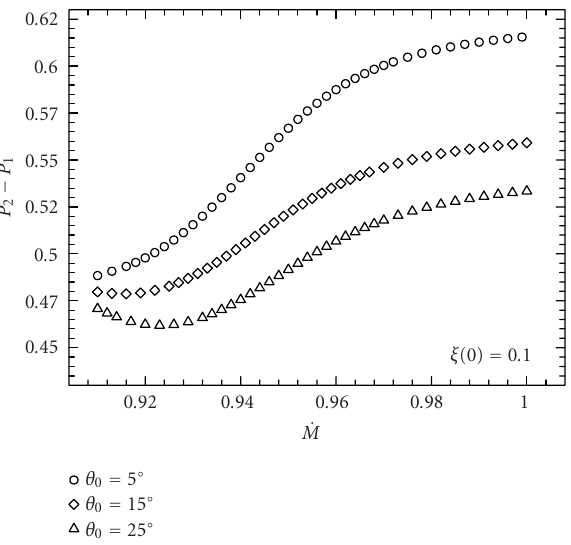
Figure 17: The computed compressor static pressure rise versus in- let incidence angle.